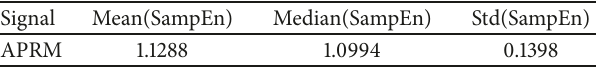
Figure 6: Tracked IMF (IMF 3) of interest and its associated instantaneous frequency (IF) around 0.5 Hz computed through the Hilbert-Huang transform. Table1:Mean(SampEn),Median(SampEn),andstd(Sampen)ofthe analyzed